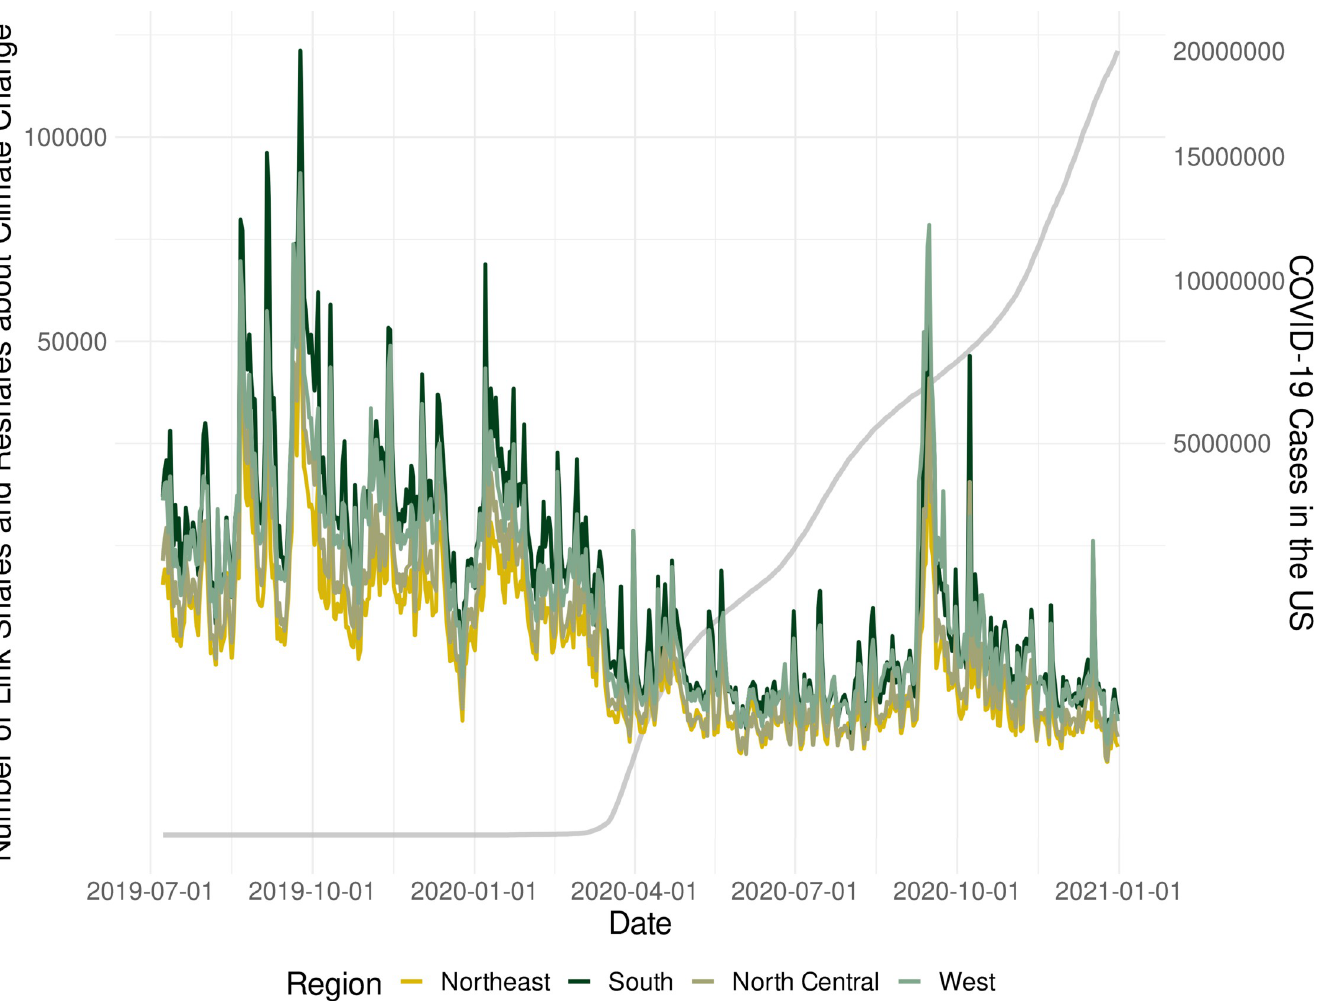
Fig 2. Absolute number of climate change link shares and reshares in the United